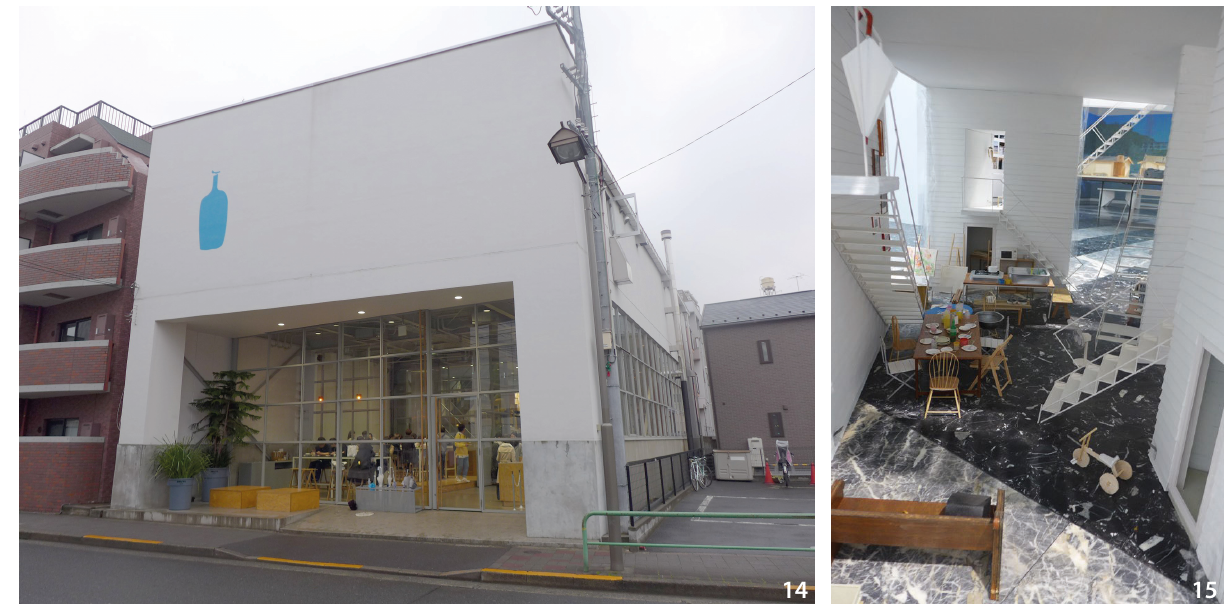
Figure 14 A coffee shop in a converted warehouse in Kiyosumi Shirakawa (Source: the author). Figure 15 Share house in “En: Art of Nexus” exhibition (Source: the